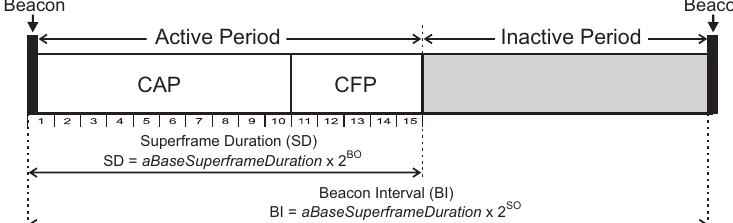
Figure 1. IEEE 802.15.4 Superframe